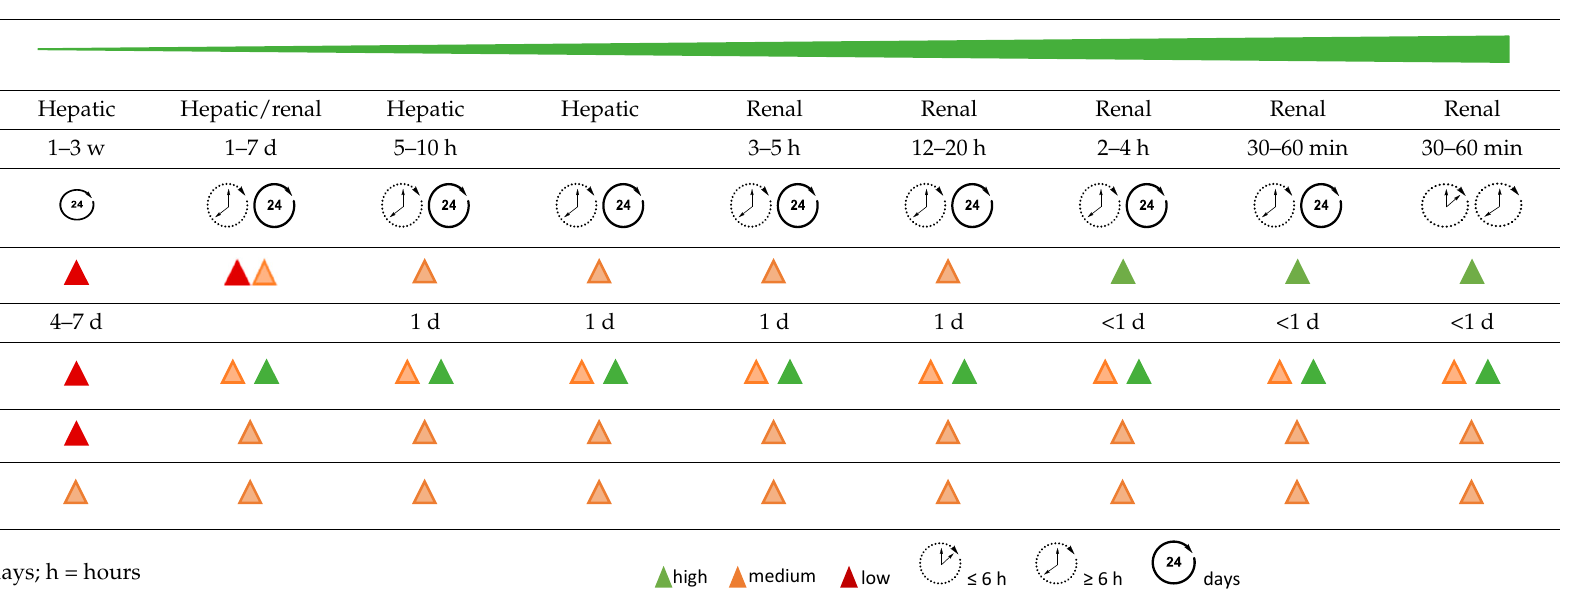
Table 3. Summary of the key properties of intact antibodies, antibody fragments, nanobodies, and affibodies [10,17].